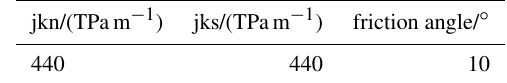
Figure 8. Sketch to illustrate Timoshenko’s solution.